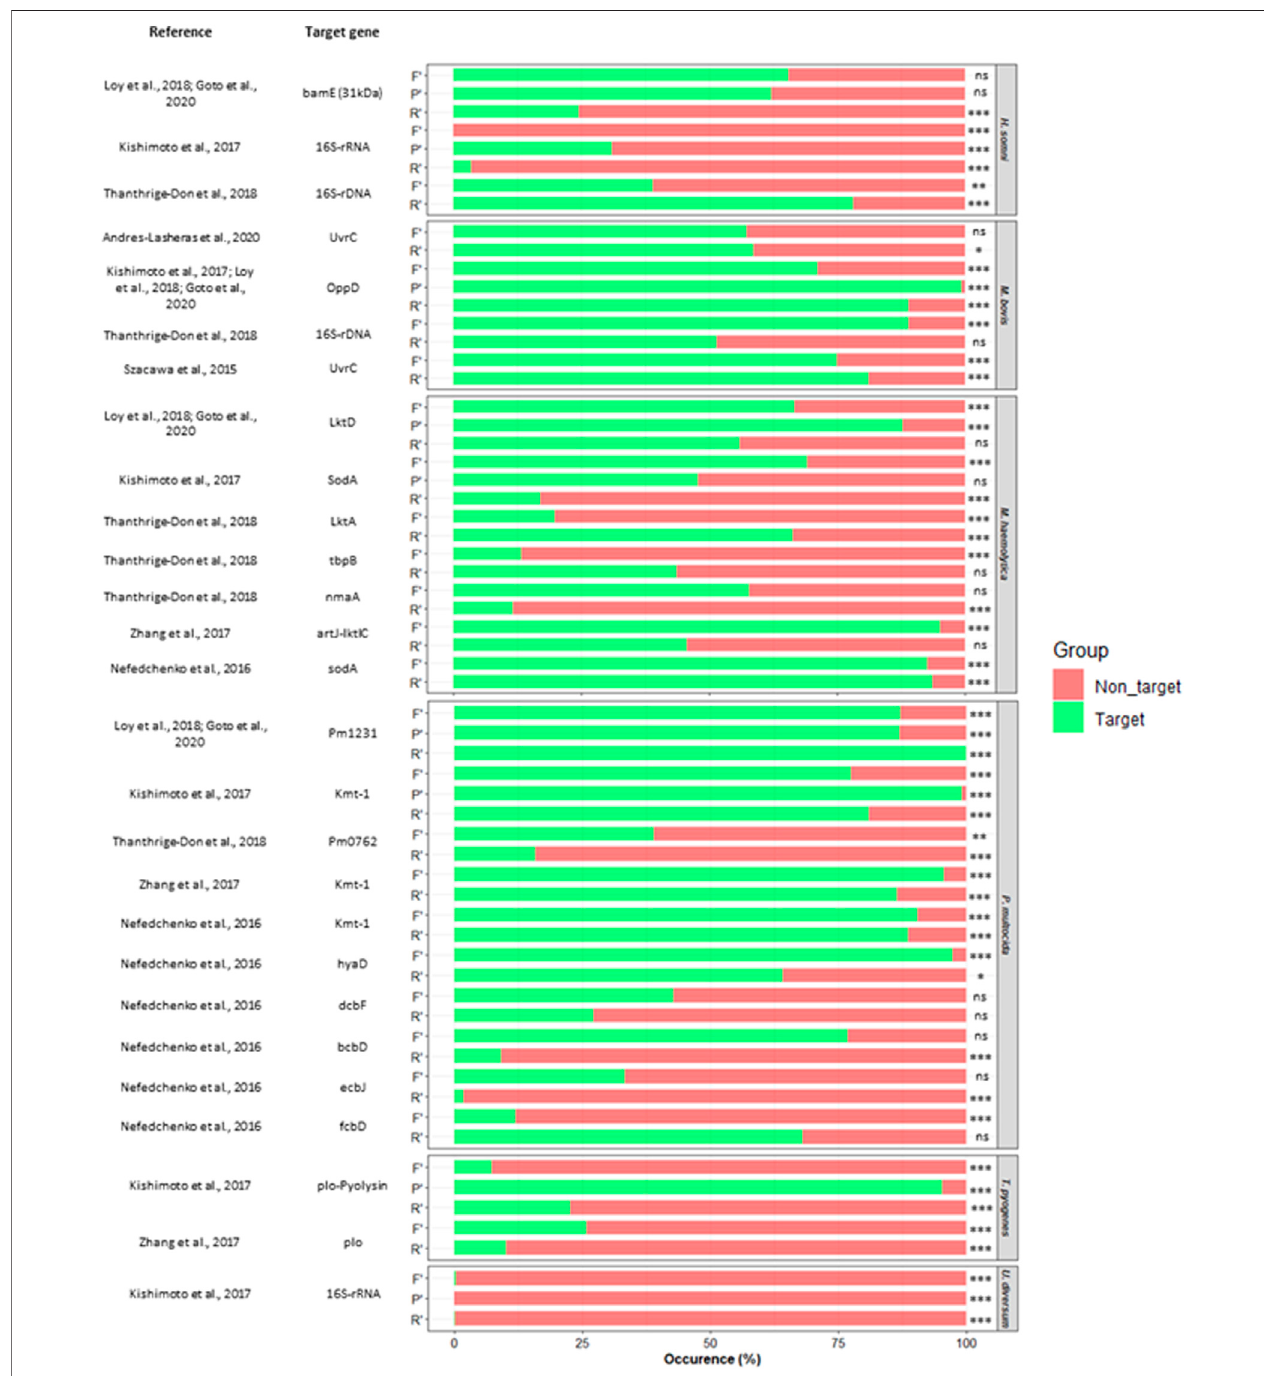
FIGURE 3 | Occurrence of target and non-target sequence alignment for published primer (F ′ forward, R ′ reverse) and probe (P ′ ) sequences targeting BRD associated bacterial pathogens H. somni; Histophilus somni, P. multocida; Pasteurella multocida, T. pyogenes; Trueperella pyogenes, M. bovis; Mycoplasma bovis, M. haemolytica; Mannheimia haemolytica, U. diversum; Ureaplasma diversum. Fisher ’ s exact test; p > 0.05 ns, p ≤ 0.05 *, p ≤ 0.01 **, p ≤ 0.001 ***.